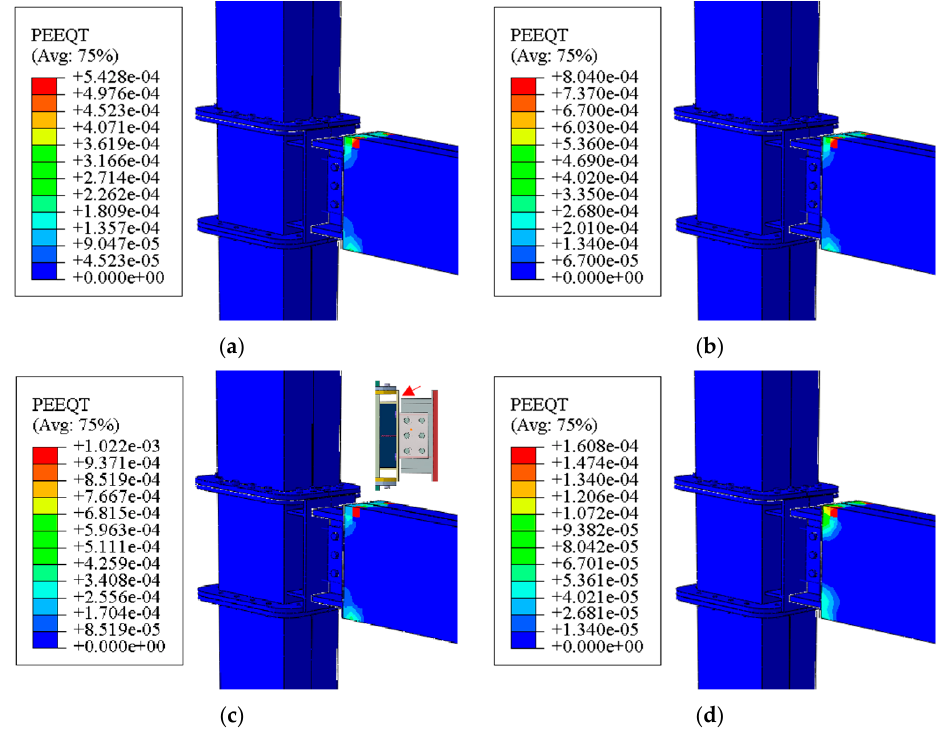
Figure 29. Comparison of joint failures: ( a ) J3-1; ( b ) J3-2; ( c ) J3-3; ( d ) J3-4.